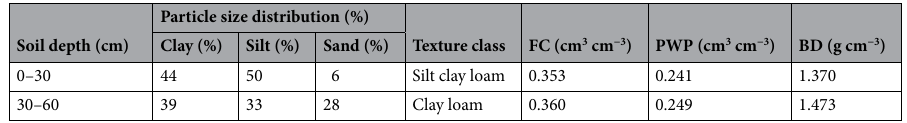
Table 2. Physical properties of the experimental soil. Clay (< 0.002 mm), silt (0.002–0.05 mm), sand (0.05–2 mm) (USDA classification). FC: field capacity; PWP: permanent wilting point; BD: bulk density.